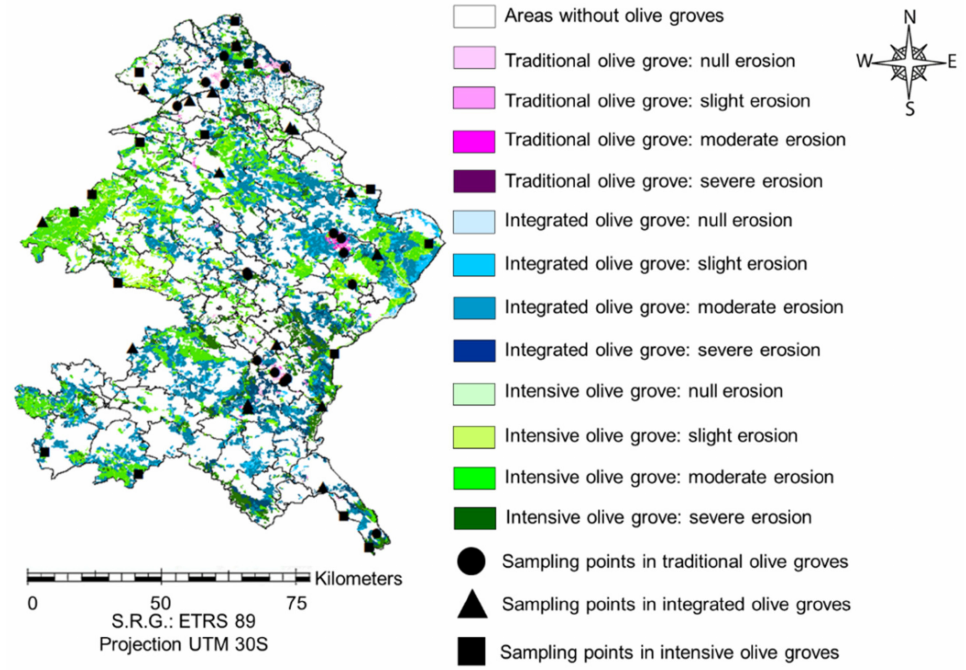
Figure 2. Sampling design carried out in the PDO Norte Alentejano, incorporating olive grove management, soil erosion levels, and sampling